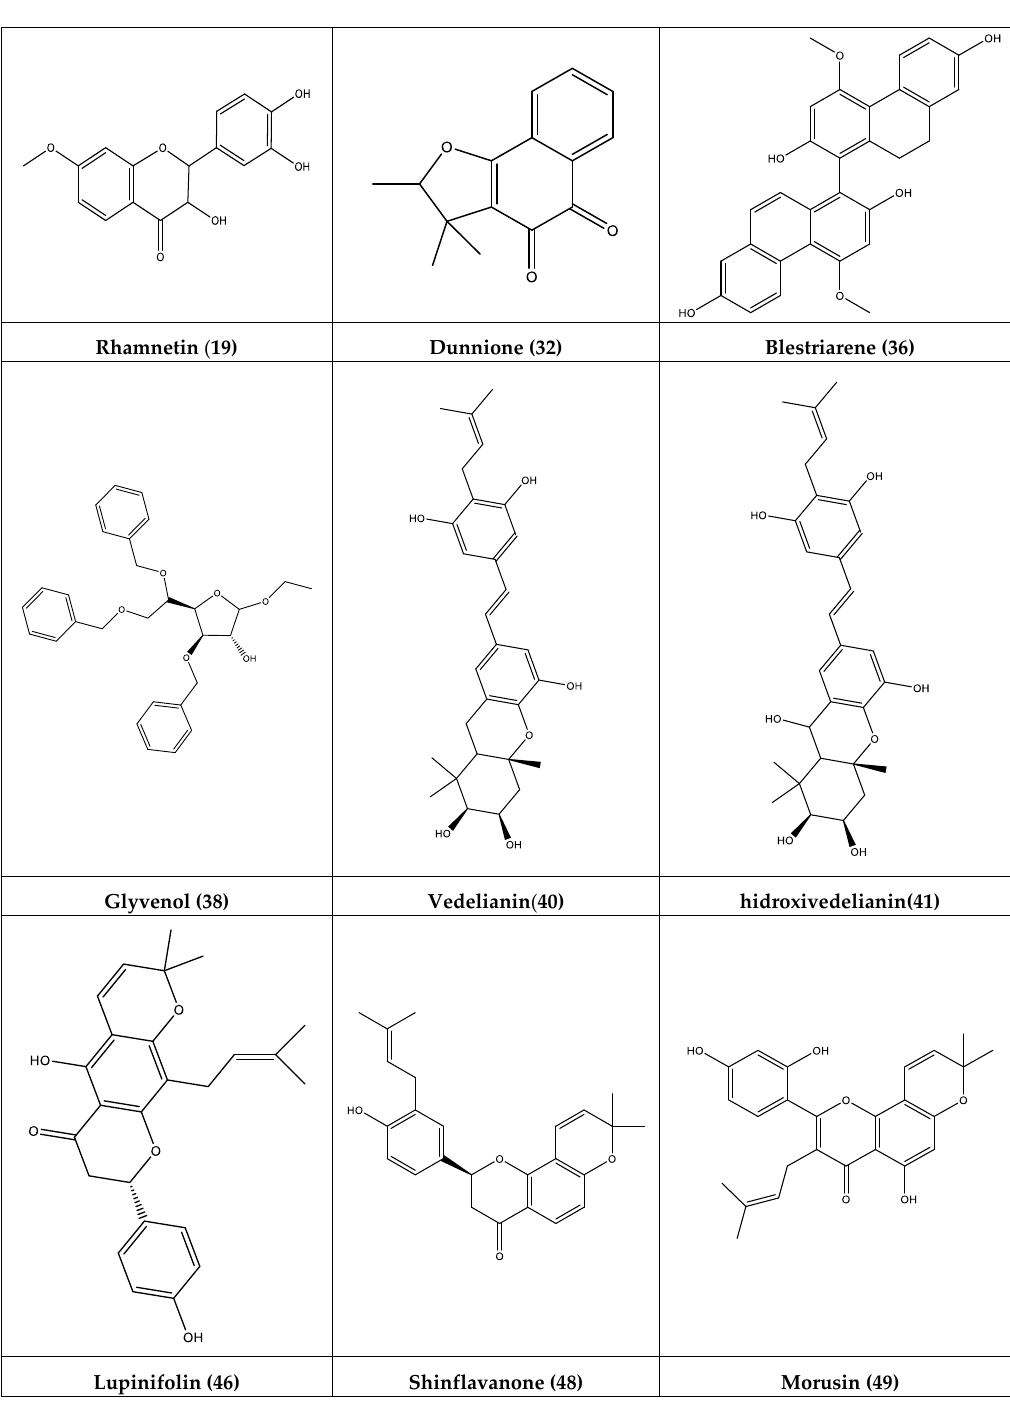
Figure 3. Structures of some newly reported compounds in ZpRe resin.